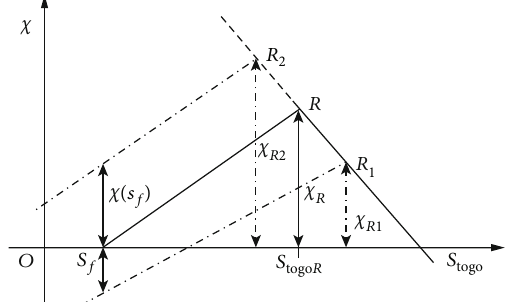
Figure 1: Geometric illustration of the principle for the bank